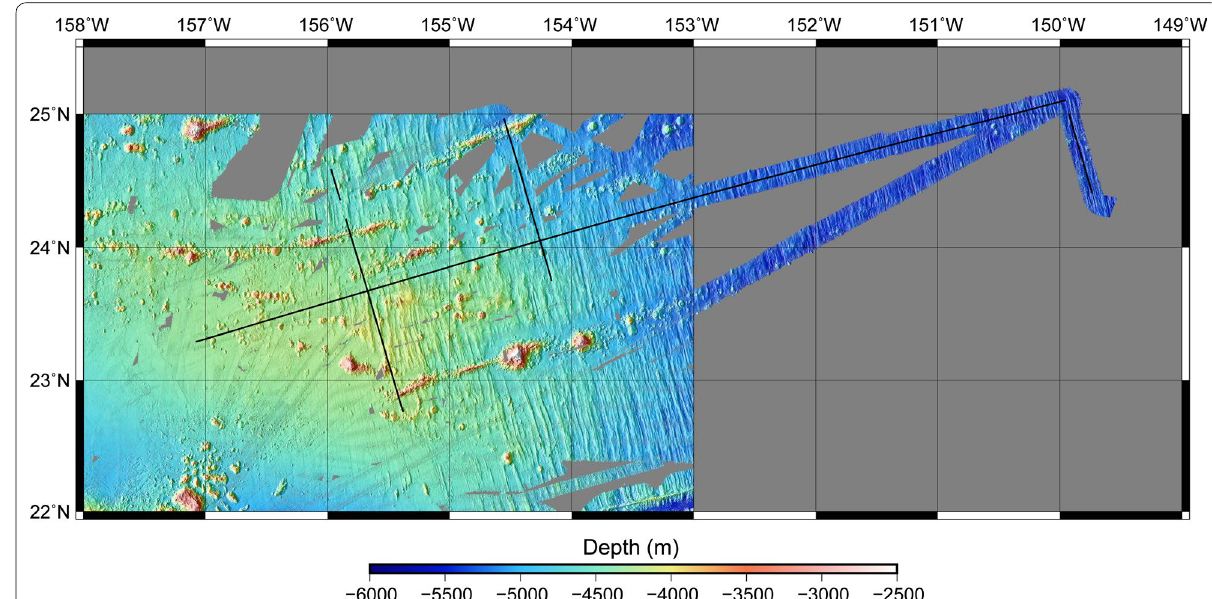
Fig. 3 Multi-beam bathymetry compiled from this survey and from multi-beam bathymetry and backscatter synthesis data for the main Hawaiian Islands (http://www.soest .hawai i.edu/HMRG/multi beam/). The seismic lines of this study are shown by solid black lines